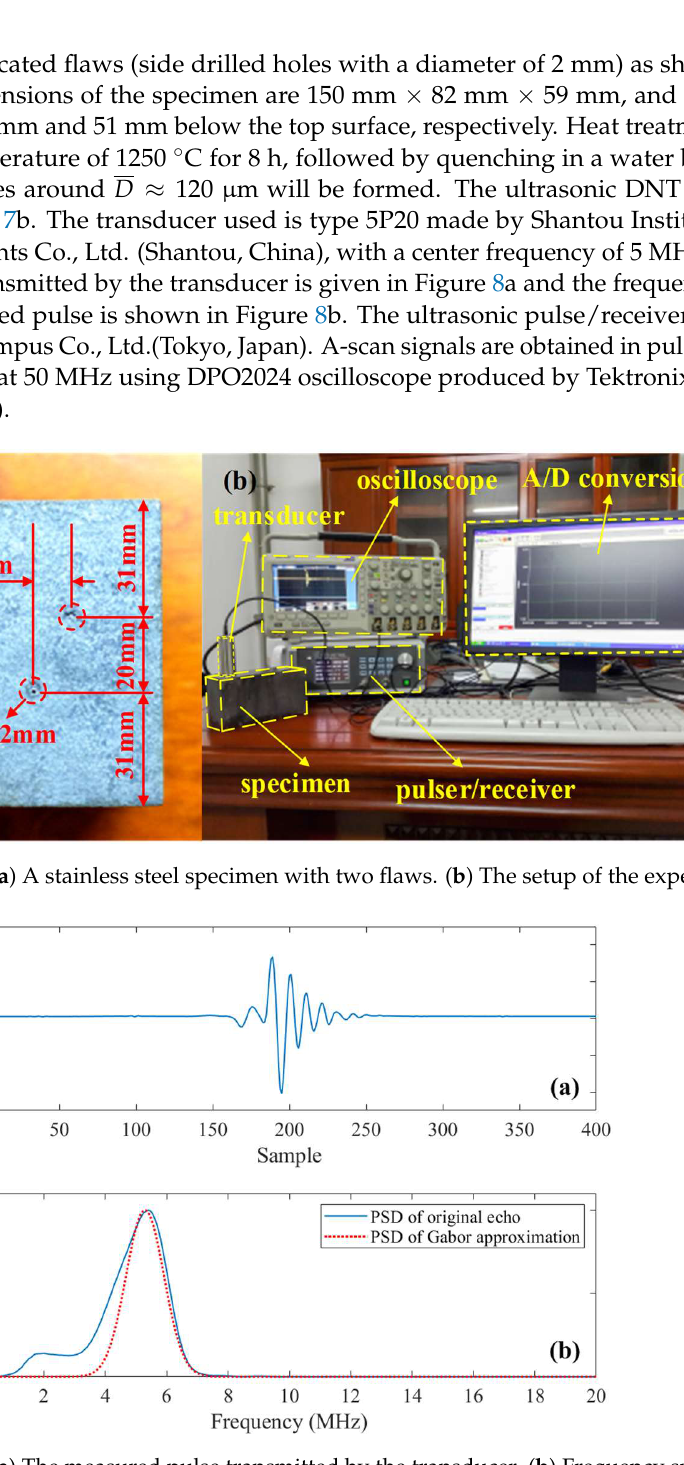
10 of 14 Figure 6. ( a ) The analyzed signal segment containing two flaw echoes, NSNR = 0.5946. ( b ) De-noised signal by our method along with noise-free flaw echoes, NSNR = 0.9488 (blue line: reconstructed signal; red line: original noise-free echoes). ( c ) De-noised signal by DWT (level-4 sym25) along with noise-free flaw echoes, NSNR = 0.7378 (blue line: reconstructed signal; red line: original noise-free